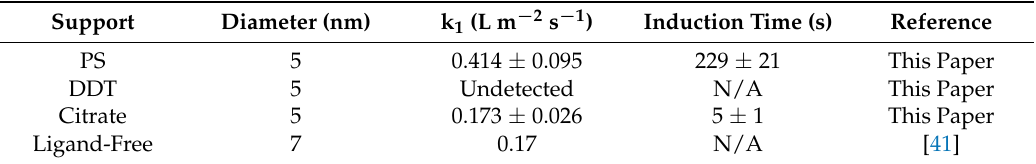
Table 1. Rate constants and induction times for various gold nanoparticles. PS, polystyrene; DDT dodecanethiol-stabilized gold